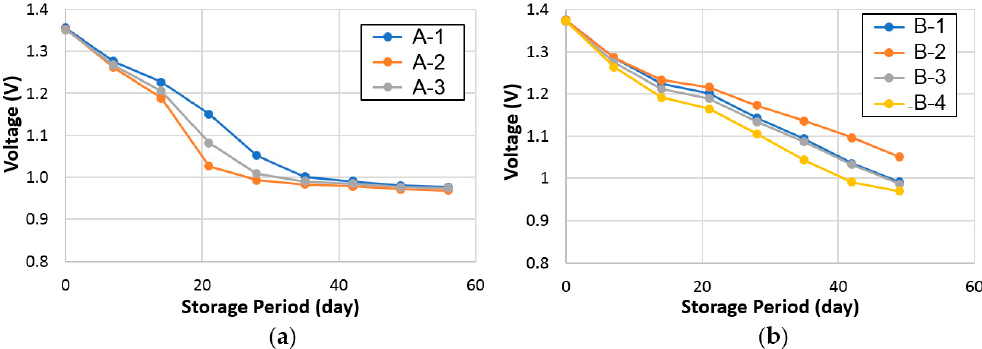
Figure 8. Open-circuit voltages of ( a ) cell A (set of three), and ( b ) cell B (set of four) stored at − 10 °C.